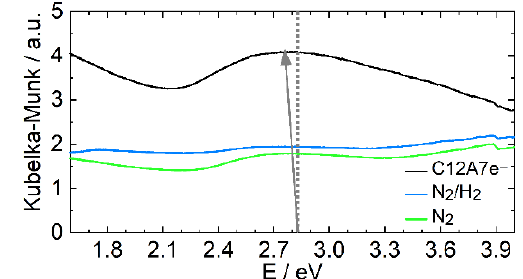
Figure 5. ( Left ): DSC (heat flow, exothermic up, solid) and TG (m/m total , dashed) curves under forming gas (95% N 2 /5% H 2 ) for (d) C12A7e − (3C) shown in red and (a) C12A7 shown in black. 10 mg of sample each were heated with a rate of 10 K · min − 1 from RT to 1173 K. The dotted blue lines indicate the region of the color change for C12A7e − as shown in Figure 4. ( Right ): Kubelka–Munk-transformed DRUVVis spectra for (d) C12A7e − (3C) shown in black and the resulting powders after reactivity tests at 723 K under forming gas (blue) and N 2 (green). The dotted line at 2.83 eV corresponds to the absorption peak maximum for N e = 1 · 10 18 cm − 3 [21]. The arrow indicates the shift with increasing N e